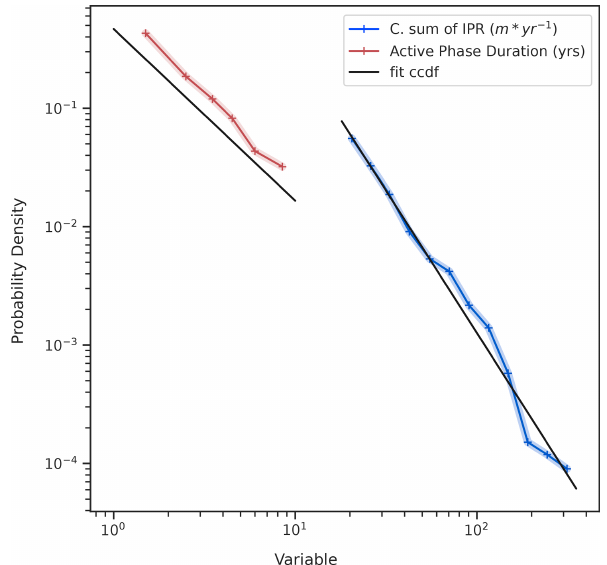
Figure 13. Estimation of empirical probability densities for the cu- mulative sum of IPR (blue) and surge active-phase duration (red). Solid black lines indicate power law